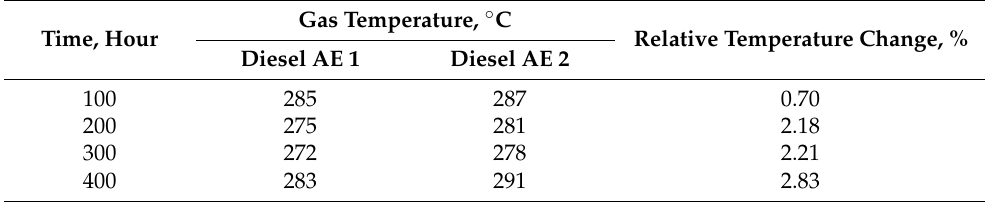
Table 7. Change in the temperature of after-cylinder gases in diesel engine 5L23/30 MAN-B&W Diesel Group under different experimental